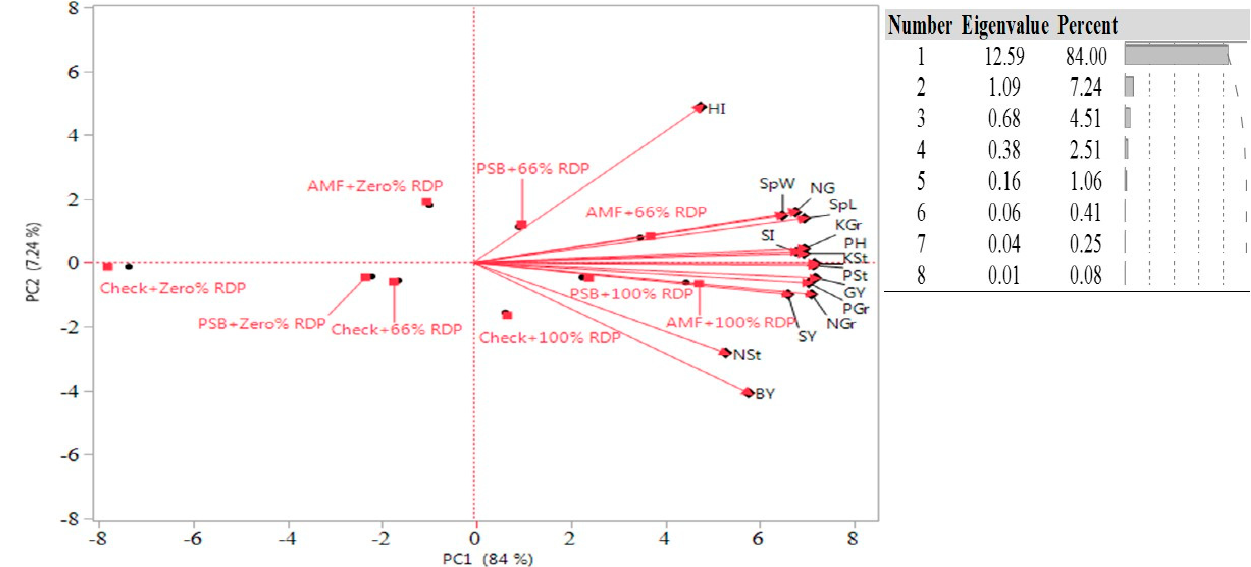
Figure 3. Biplot of principal component analysis based on the correlation matrix applied to plant growth traits, yield, and its components as well as biochemical traits. Abbreviations: PH, plant height; SpL, spike length; SpW, spikes weight; NG, number of spikes plant − 1 ; SI, 1000-grain weight; GY, grain yield; SY, straw yield; BY, biological yield; HI, harvest index; NGr, N uptake in grains; NSt, N uptake in straw; PGr, P uptake in grains; PSt, P uptake in straw; KGr, K uptake in grains and KSt, K uptake in straw. Different letters indicate significant differences at p ≤ 0.05 according to Duncan’s multiple range test.